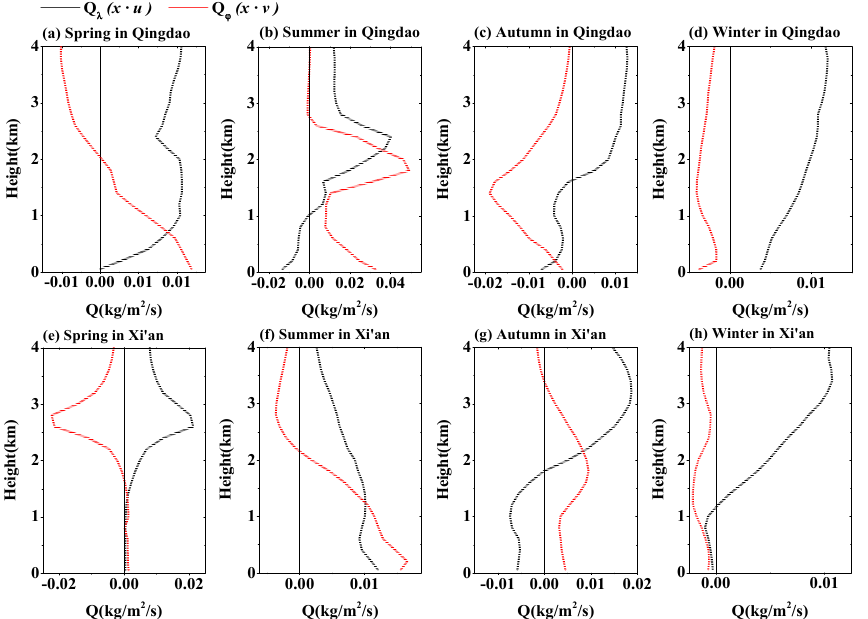
Figure 13. Vertical profiles of the WVFs in ( a ) spring (Qingdao), ( b ) summer (Qingdao), ( c ) autumn (Qingdao), ( d ) winter (Qingdao), ( e ) spring (Xi’an), ( f ) summer (Xi’an), ( g ) autumn (Xi’an), and ( h ) winter (Xi’an).